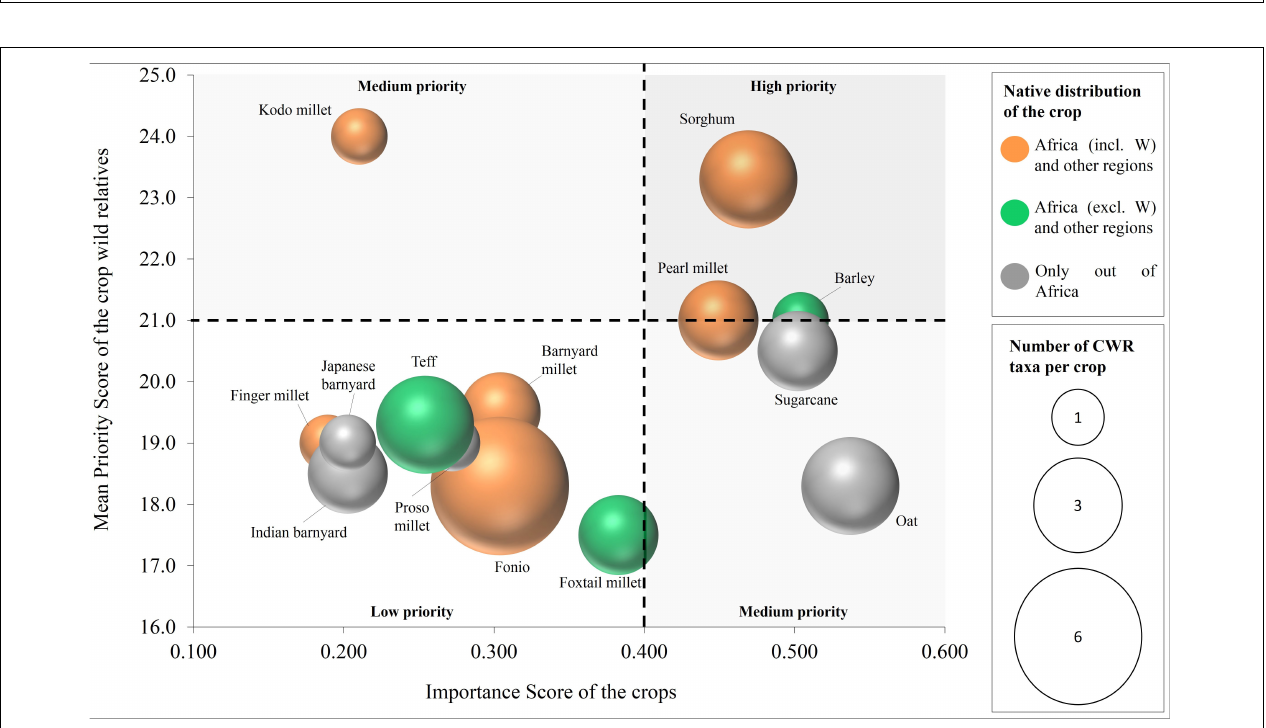
FIGURE 5 | Comparison of the importance of the 14 Poaceae crops studied and their CWR in Cabo Verde. The Importance Score concerns the food supply and agricultural production metrics of the crops and the mean Priority Score represents the nine criteria used as a proxy to prioritize the CWR (for details see section “Importance and Priority Scores”). The size of the circles indicates the number of CWR taxa per crop. The colours indicate the native distribution of the crop.